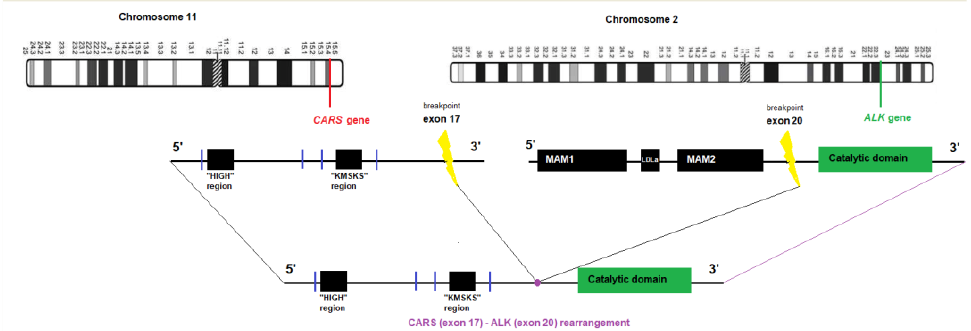
Figure 2. Graphical view of the CARS-ALK fusion transcript.